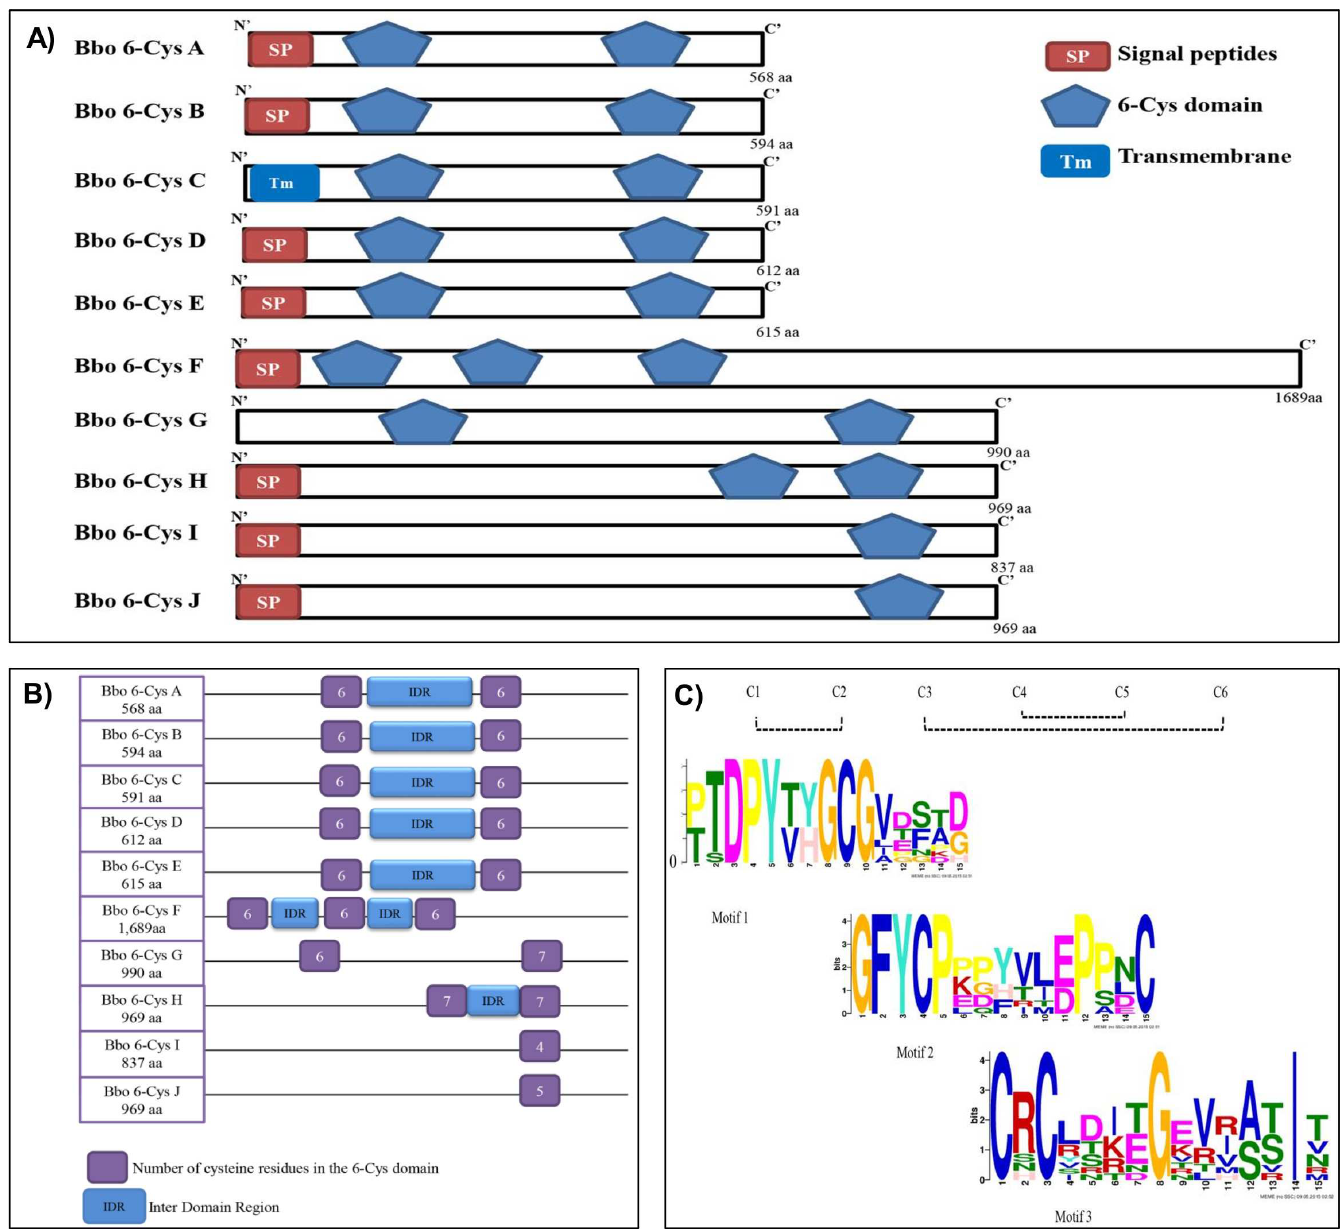
Fig 2. Characterization of Bbo 6-Cys proteins and 6-Cys domain. A. Schematic representation of 6-Cys family proteins. The number and relative localizationof the 6-Cys domains, represented as blue boxes, the predicted signal peptides (SP) and transmembrane domains (Tm), and the number of amino acids are indicated. B. Schematic representation of the arrangement and number of the 6-Cys domains in each of the B . bovis 6-Cys proteins. The number of residues found in each domain is represented inside each box. The lengths of the inter-domainregions (IDR) in the proteins containingtwo 6-Cys domains are relativelysimilar at 163,161,159,162, 164, in the A, B, C, D and E proteins, whereas it contains 227 and 521 aa in H and G’s 6-Cys domain, respectively. Since protein F has three 6-Cys domains so it has two IDRs with lengths 164 aa and 214 aa for IDR1 and IDR2 respectively. C . Schematic representation of the predicteddisulfidebonds in the B . bovis 6-Cys proteins using the Prosite program (top). Descriptionof the three conserveddomains identifiedin the 6-Cys domains among the ten 6-Cys B . bovis proteins using MEME analysis. Amino acids are represented using letter symbols. The highest letters represent strictly conservedresidues. Font sizes are proportional to the relative frequency of each residue for each